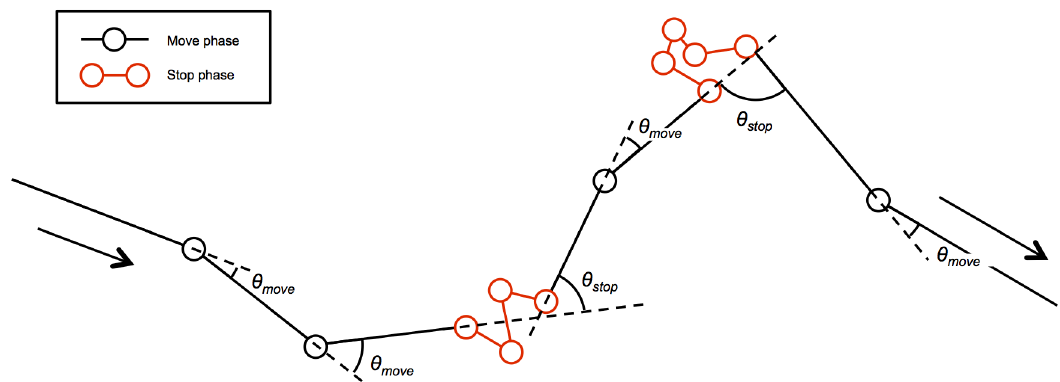
Fig 3. Schematic diagram of turn angles in a ‘move’ phase ( θ move ) and ‘stop’ phase ( θ stop ).